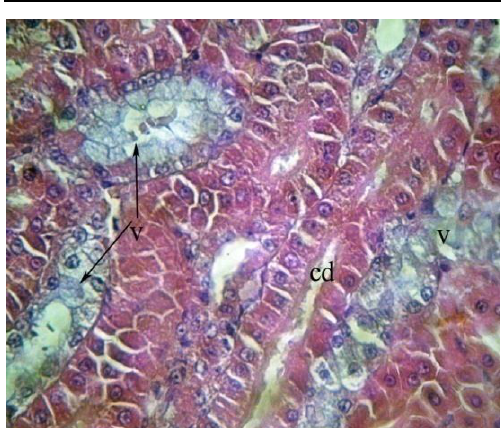
Fig.10:photomicroscope illustrate the p. proximal convoluted tubules d. distal convoluted tubules v. vesicles or vacuoles t. thin limb of Henle. (HandE, X40)